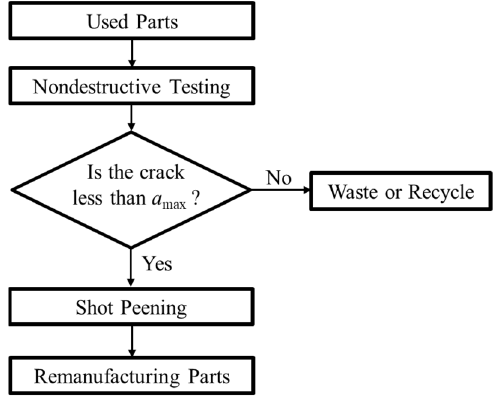
Figure 12. Flowchart of remanufacturing process with shot peening .